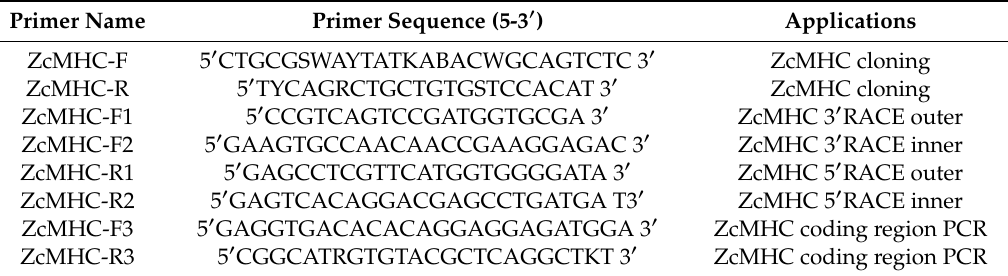
Table 1. Primer sequences and function used in this